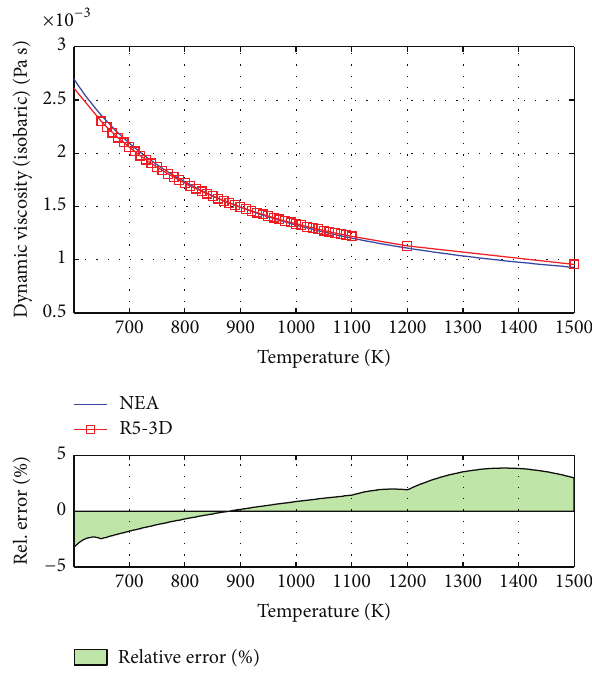
Figure 12: Lead liquid dynamic viscosity, original R5-3D “tpf” file versus NEA